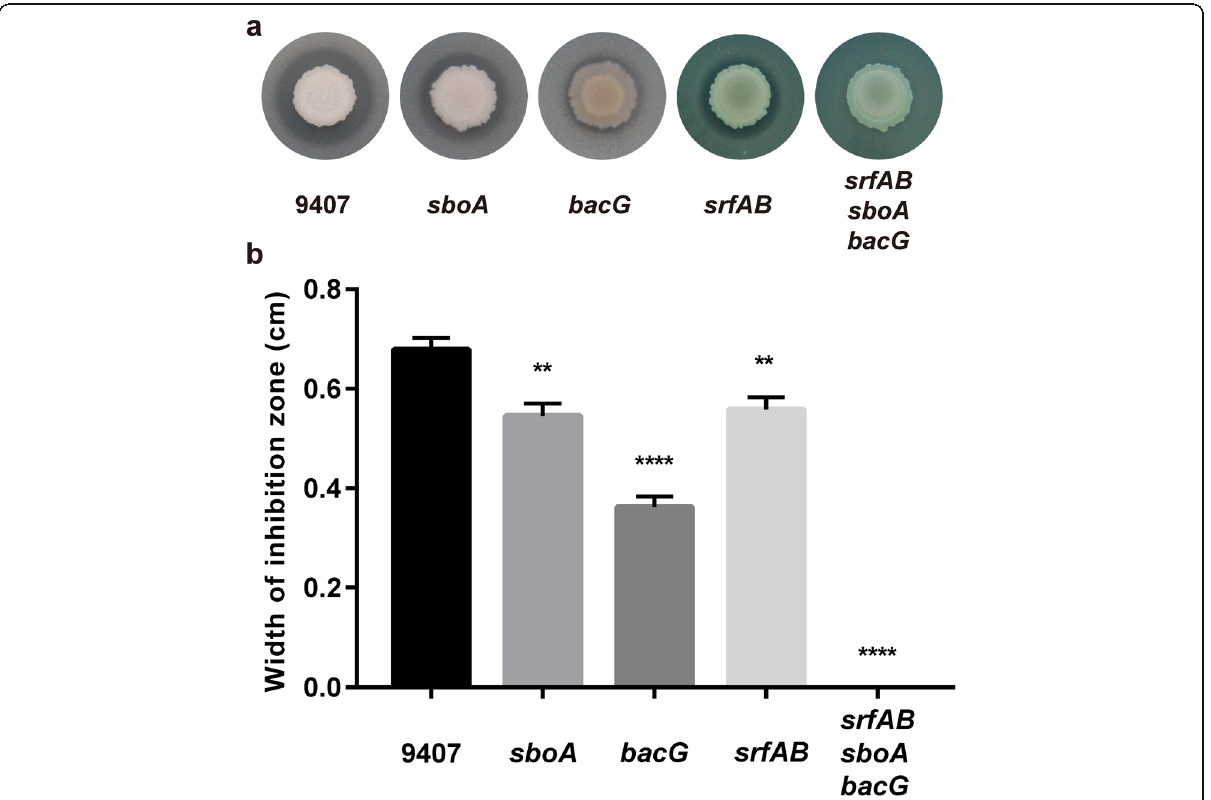
Fig. 4 Antimicrobial activity of the sboA and bacG mutants against A. citrulli MH21. a The antimicrobial activity of the sboA and bacG mutants was decreased compared with that of the wild-type B. subtilis 9407 strain. b The inhibition zone of B. subtilis 9407, the sboA and bacG mutants against A. citrulli MH21. Antibacterial activity was indicated by the diameter of the inhibition halo minus the diameter of the colony. The statistical analysis was performed using GraphPad Prism 7 software by one-way ANOVA with the Dunnett test ( P < 0.05). The variation was recorded as mean ± SE (****: P < 0.0001, ***: P < 0.001, **: P < 0.01, *: P <